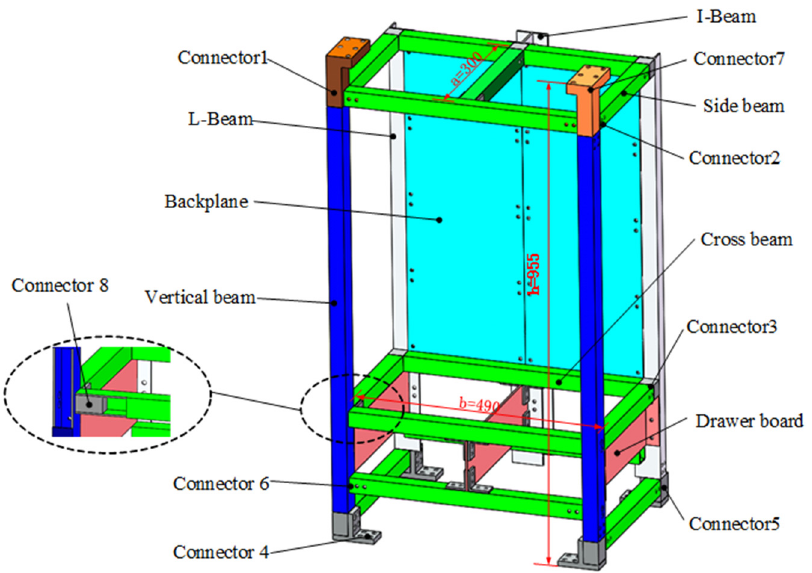
Figure 1. Composition of the experiment rack